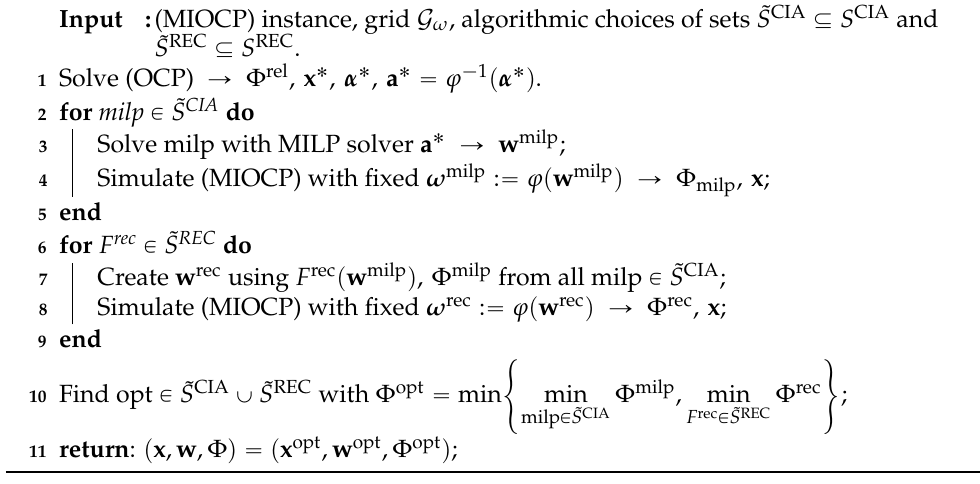
Algorithm 1: Decomposition of